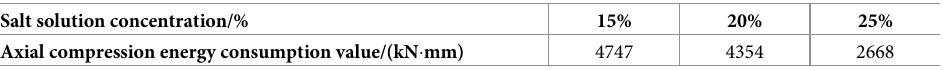
Table 10. Total energy consumption of specimens strengthened with SMA in different concentrations of salt solu- tion under axial